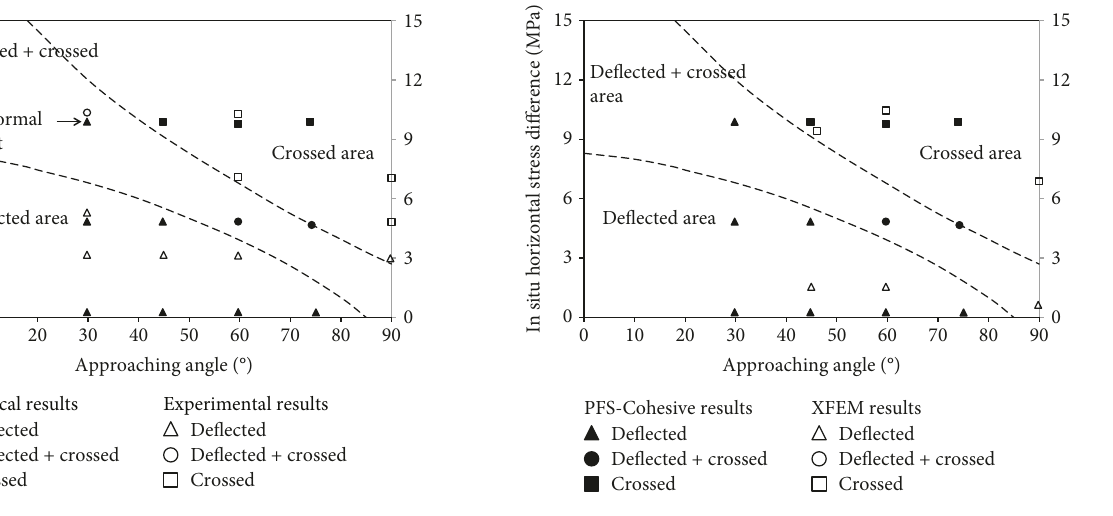
Figure 16: Result comparison between PFS-Cohesive method and XFEM